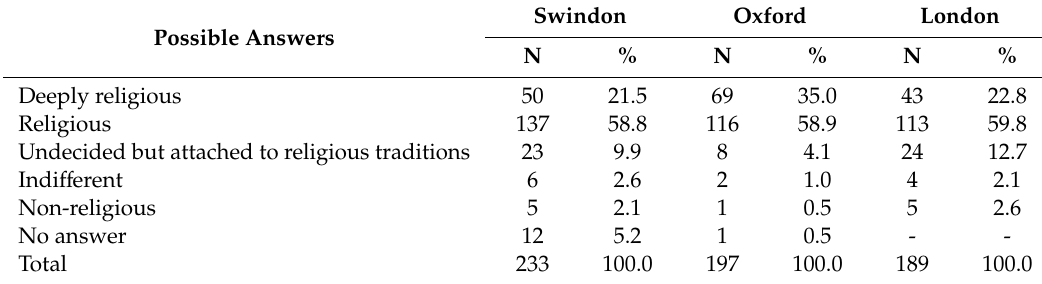
Table 1. Which of the following best describes your attitude towards faith and